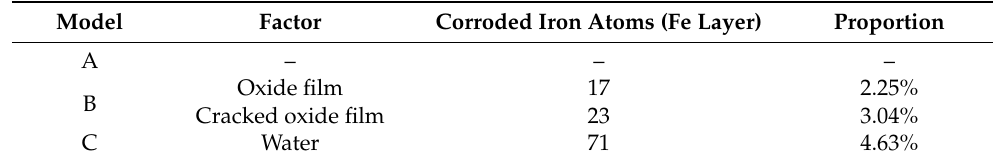
Table 2. Corroded iron atoms of models.